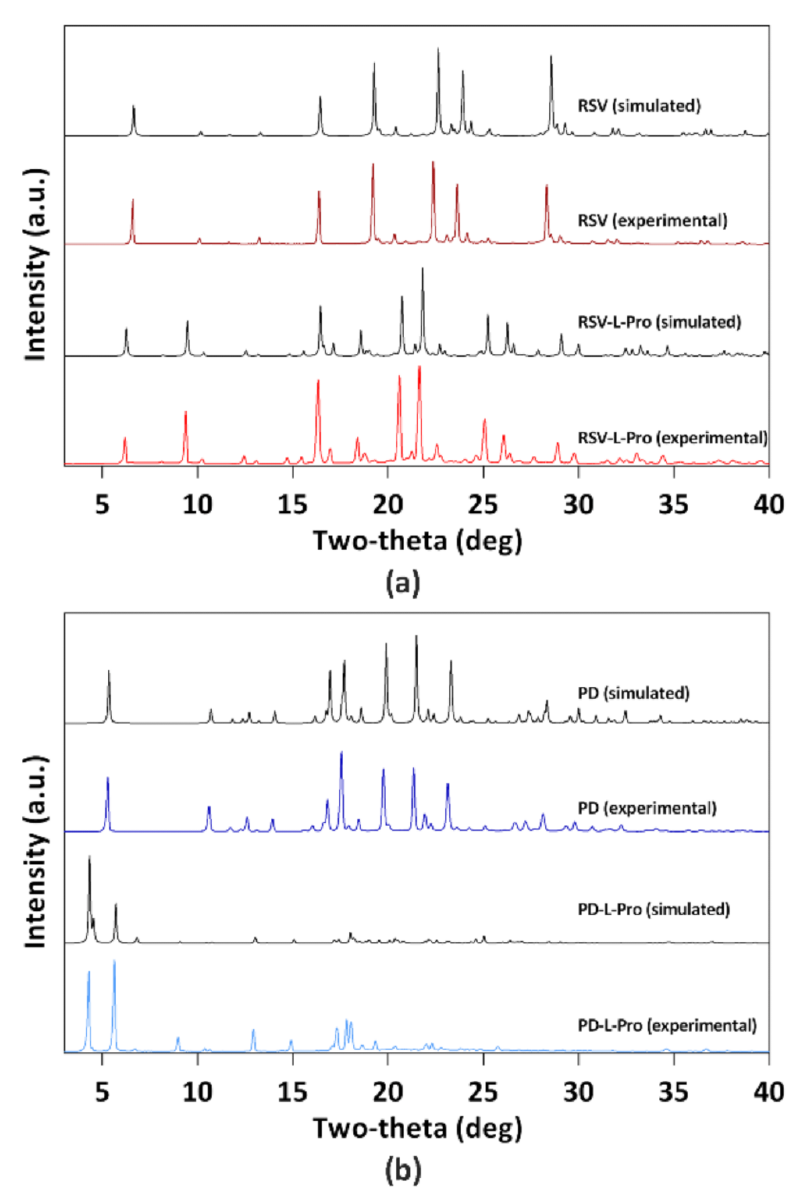
Figure 2. PXRD patterns of RSV and RSV-L-Pro ( a ) and PD and PD-L-Pro ( b ) showing a good agreement between the experimental results and those simulated from single-crystal diffraction data, indicating high phase purity of all the four complexes, and thus the successful formation of new phases of RSV-L-Pro and